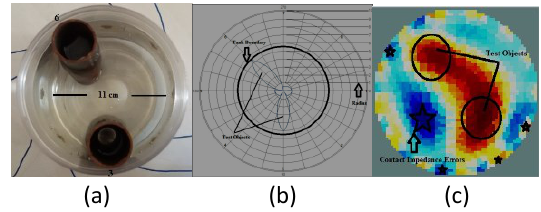
Fig. 6: (a) = actual test objects placed along the line of electrode 3 and electrode 6 respectively, (b) = test objects as located using beamforming algorithm. A thick circle represents the actual diameter of the test tank and (c) = test objects as indicated by EIDORS. The circle represents the actual object while the stars indicate the contact impedance errors.